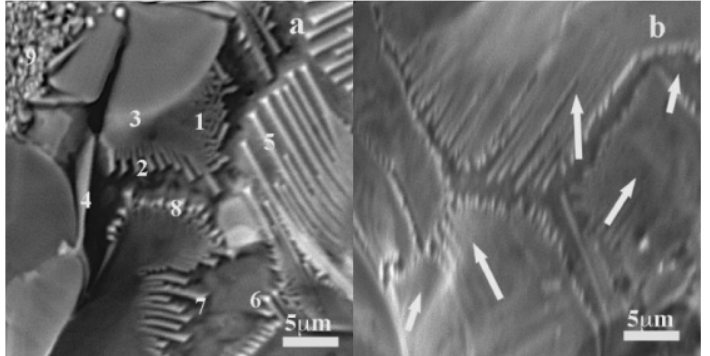
Ni Mo B Zr 45 21 6 18 10